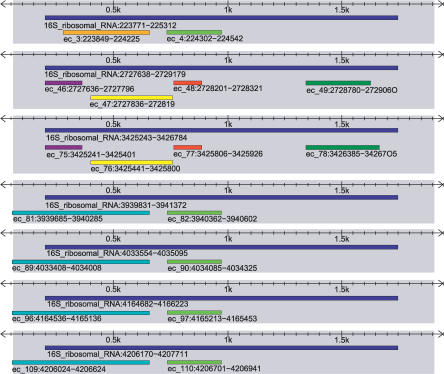
Locations of RNAz Predictions for 16S rRNAThe dark blue box is the annotated 16S rRNA. The other boxes denote the RNAz predictions. Boxes with the same color are clustered together by our clustering procedure (see Figure 2). This shows that we correctly cluster the corresponding substructures.